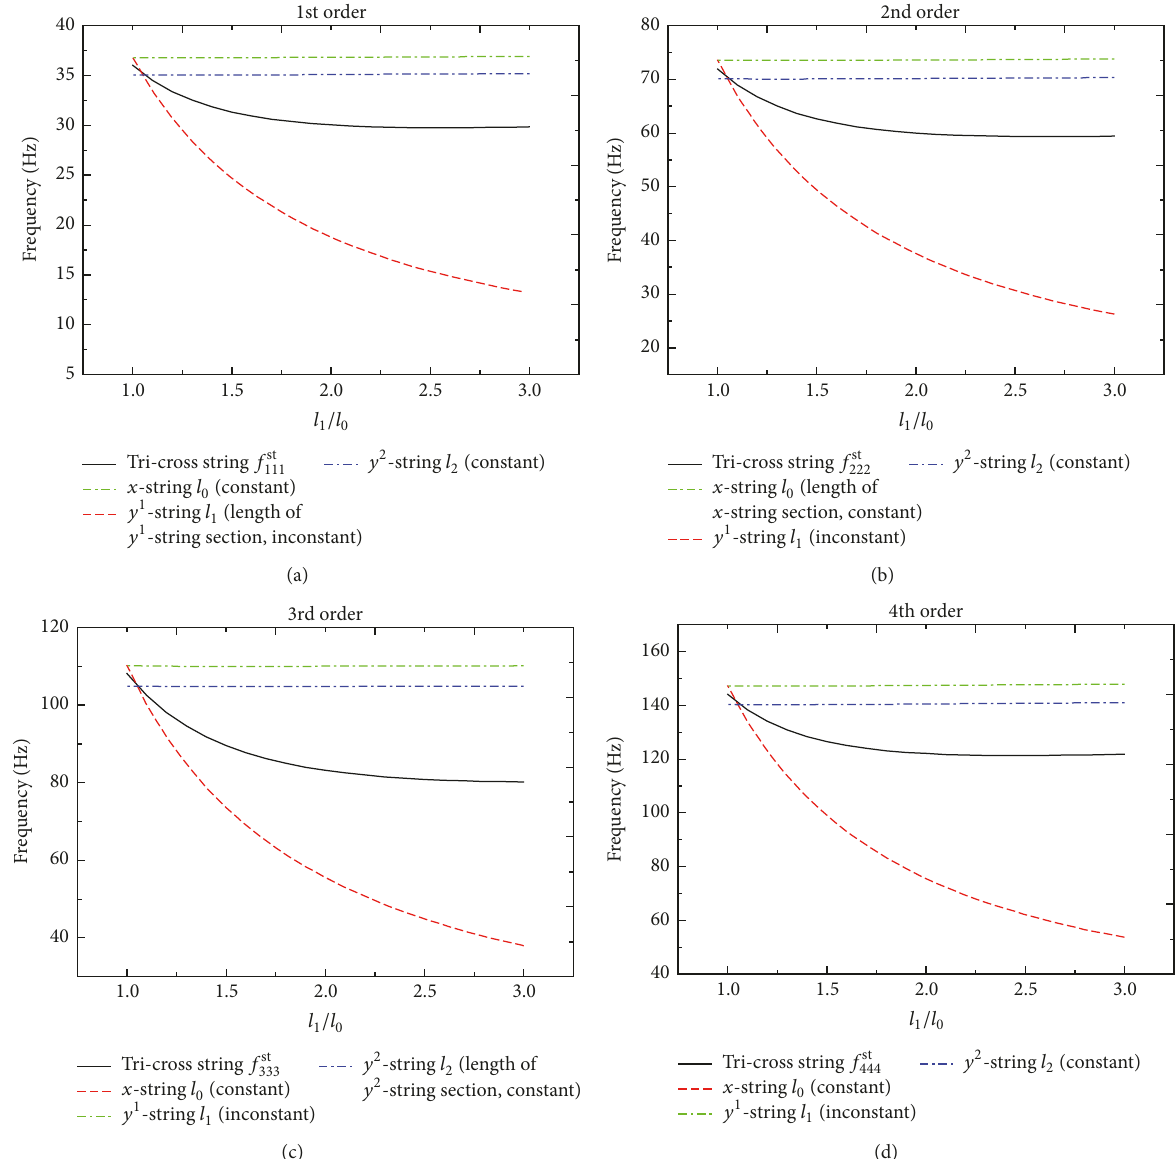
Figure 7: The influence of the length of one constituent string on the first four frequencies of the strings: (a) the first mode 𝑓 st 111 , (b) the second mode 𝑓 st 222 , (c) the third mode 𝑓 st 333 , and (d) the fourth mode 𝑓 st 444